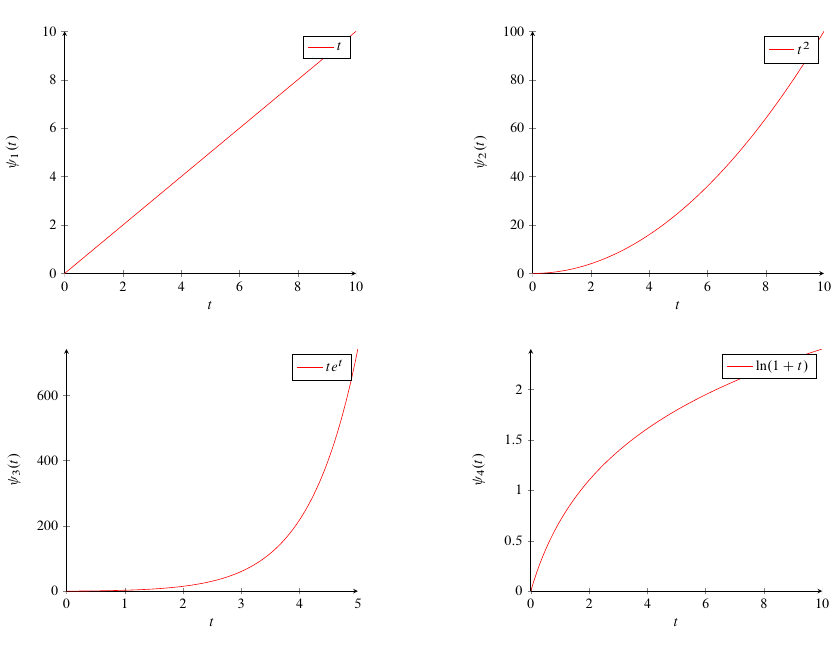
Fig. 1. Graphs of 1 ; 2 ; 3 ; 4 in Example